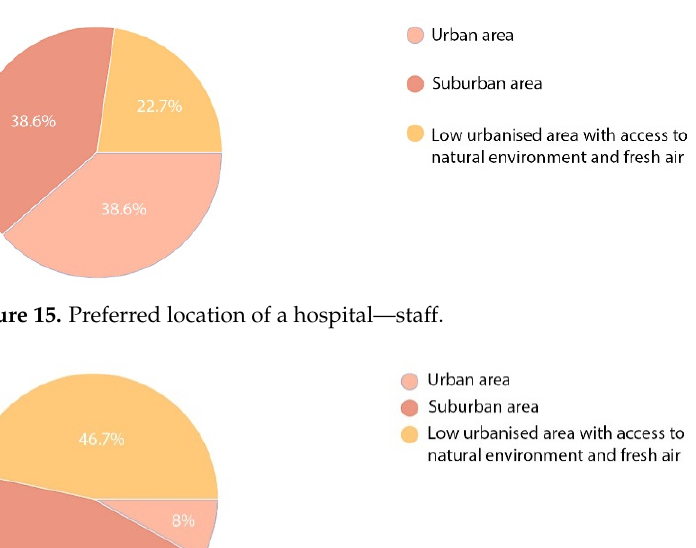
Figure 15. Preferred location of a hospital—staff .